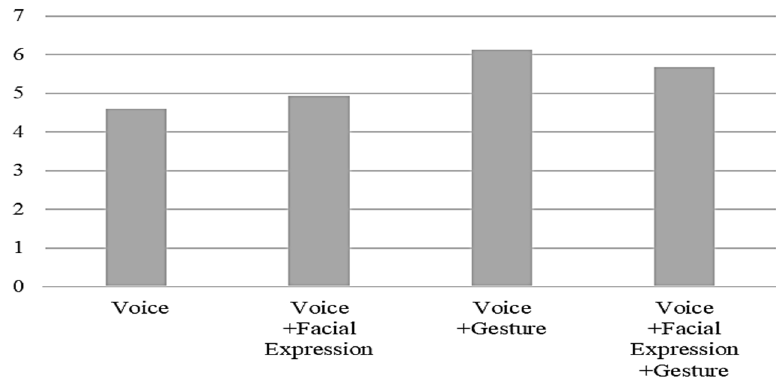
Figure 7. The degree to which the robot was perceived to have emotions by interaction type.